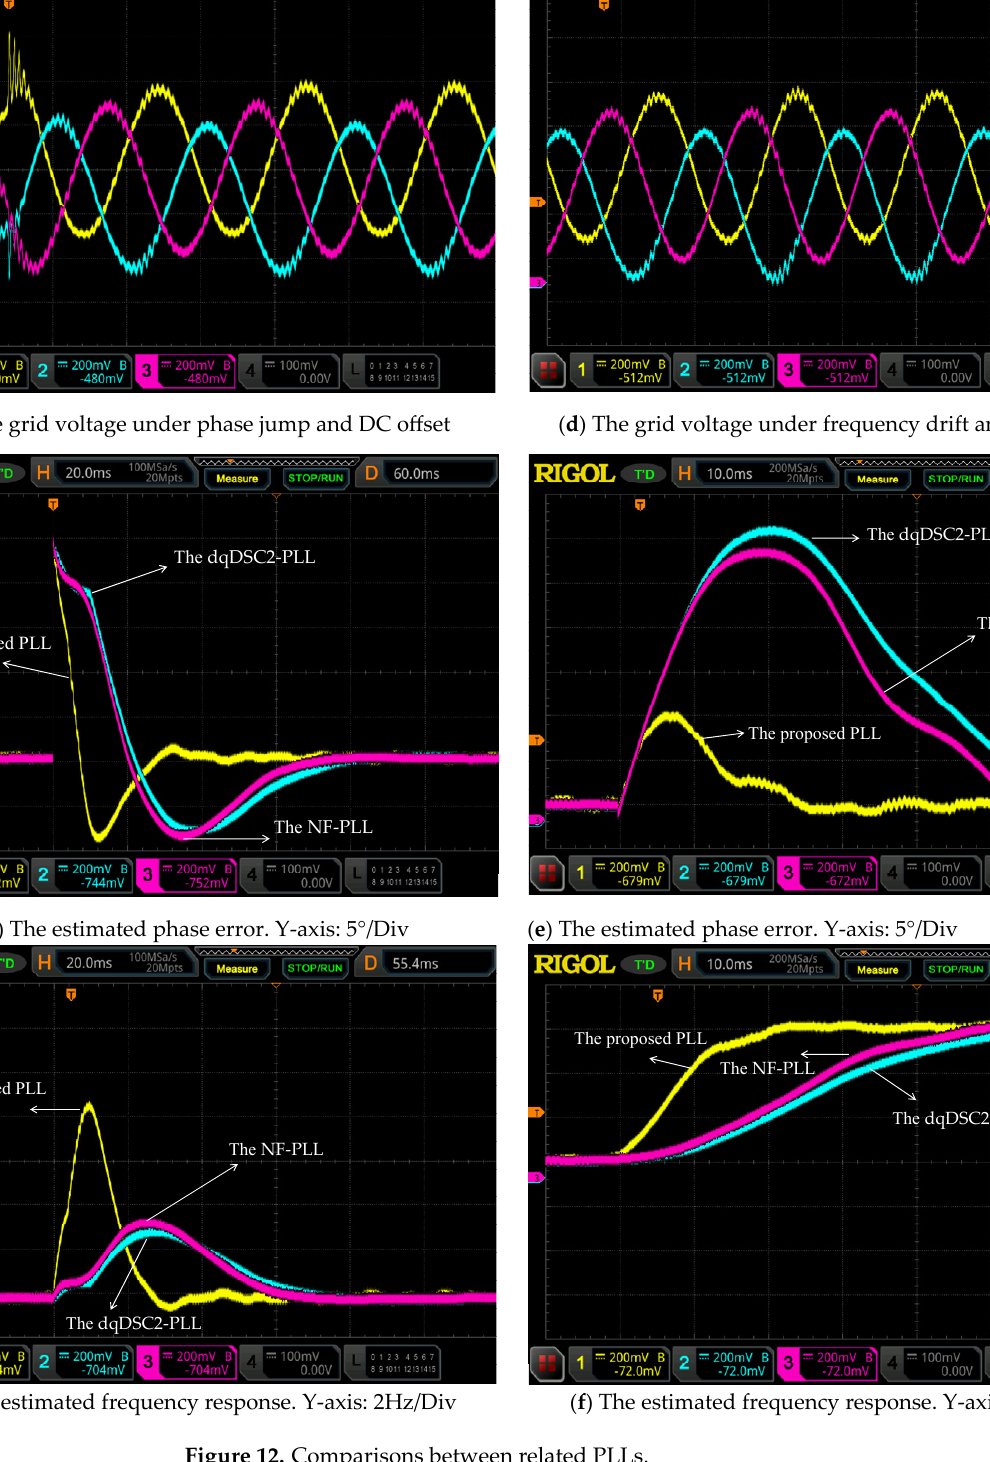
Figure 12. Comparisons between related